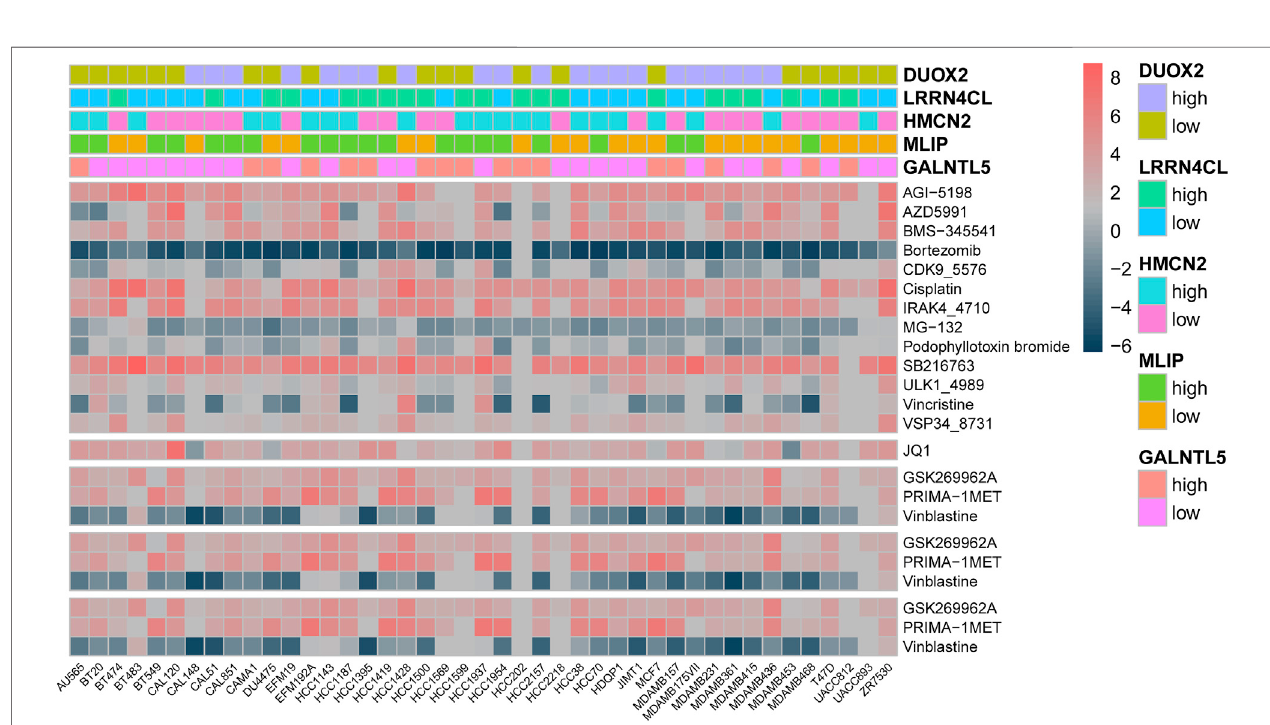
FIGURE 6 | Heatmap analysis showed that GALNTL5, MLIP, HMCN2, LRRN4CL and DUOX2 were associated with drug sensitivity of multiple agents in breast cancer cell lines.